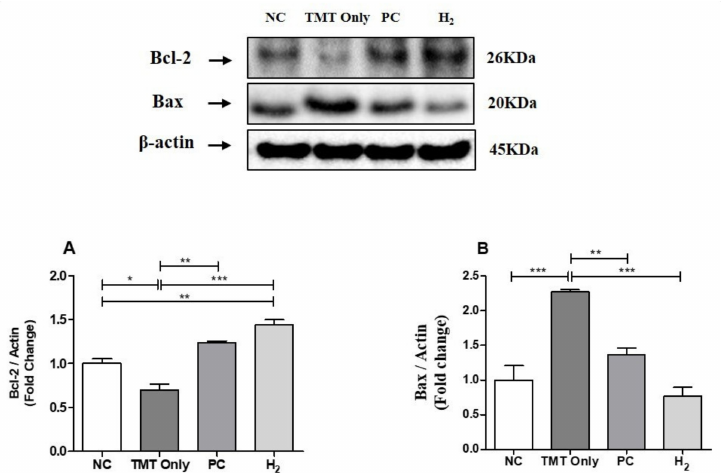
Figure 11. Effects of H 2 gas inhalation treatment on the Bcl-2 and Bax protein levels in brain lysates of TMT-induced C57BL/6 mice after four weeks. ( A ) The antibody-reactive quantified band intensity of Bcl-2 in the brain lysates, ( B ) The antibody-reactive quantified band intensity of Bax protein in brain lysates. The bar graphs represent the band intensity of each protein marker normalized to the total. The data are presented as the mean ± SD for n = 3 mice. Significant differences were analyzed with ANOVA and Tukey’s test. * p < 0.05, ** p < 0.01, *** p <